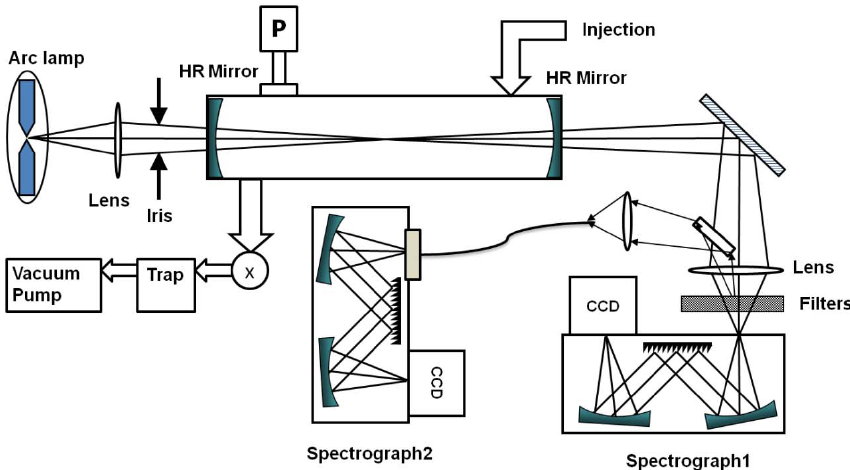
Figure 1. Schematic diagram of the IBBCEAS instrument. Spectrograph 1 recorded the IBBCEAS spectra, while spectrograph 2 recorded single-pass spectra outside of the cavity mirror reflectivity range.